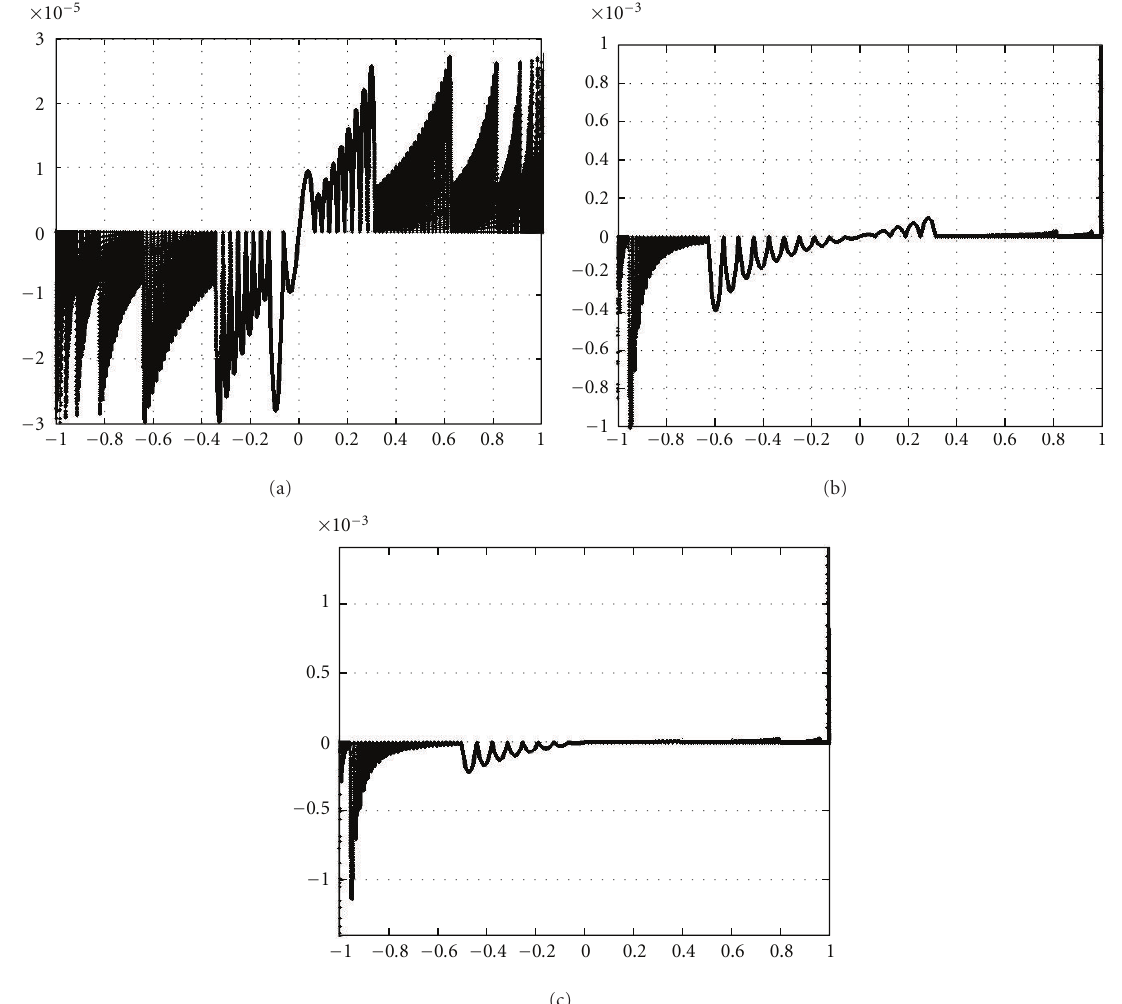
Figure 8: Approximation error obtained for the Displaced Error Function (15) using the sampling schemes α (a), β (b), and γ (c).